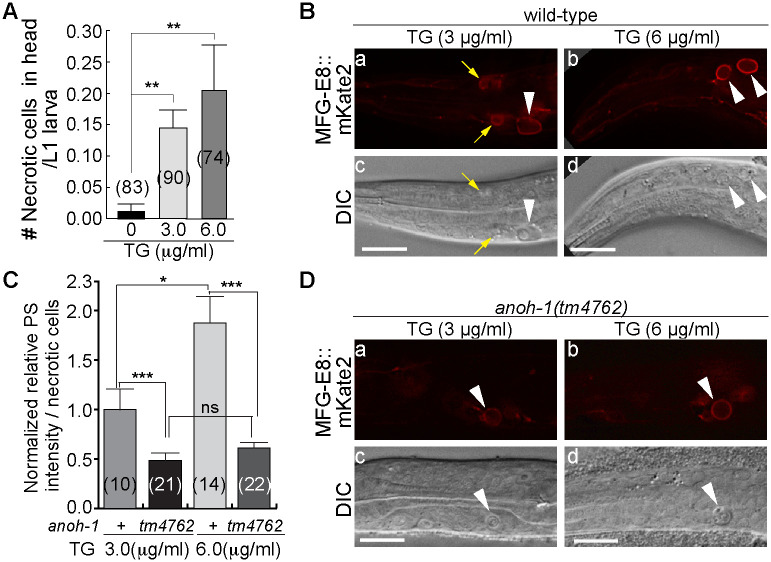
Thapsigargin induces living cells to undergo necrosis and expose PS.Adult worms carrying the integrated PS reporter Pced-1
mfg-e8::mKate2 were placed on NGM plates with different doses of thapsigargin (TG) and incubated at 25°C; their progeny were allowed to hatch into L1 larvae and promptly scored for the number of necrotic corpses in the head (A) and the intensity of PS on the surface of necrotic cells (B-D). (A) The mean numbers of necrotic cells in each wild-type L1 larva are represented in the bar graph. Error bars represent s.e.m.. “**”, 0.001<p<0.01, Student t-test. (B and D) MFG-E8::mKate2 (a, b) fluorescence and DIC (c, d) images of necrotic cells (white arrowheads) observed in the heads of wild-type (B) and anoh-1 mutant (D) larvae treated with differet doses of TG. Small yellow arrows in (a, c) mark two small, necrotic-like cells (possibly intermediate necrotic cells) that expose PS. Because of their small sizes, they were not counted as necrotic cells. Scale bars are 10μm. (C) The normalized relative MFG-E8::mKate2 signal intensities on the surfaces of necrotic cells in the heads of wild-type and anoh-1(tm4762) mutant L1 larvae are presented as the mean ratios relative that measured from worms subject to 3 μM thapsigargin treatment. Genotypes are indicated underneath the X-axis. Error bars represent s.e.m.. Numbers in parentheses represent the number of animals analyzed for each strain. “***”, p<0.001, “*”, 0.01<p<0.05, “ns”, non-sigificant, Student t-test.